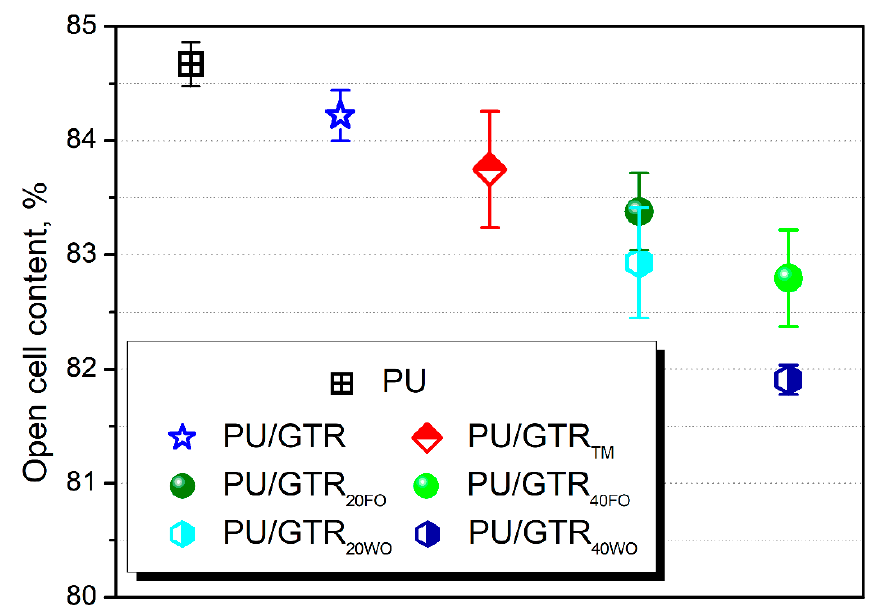
Figure 5. The open cell content of prepared polyurethane foams.